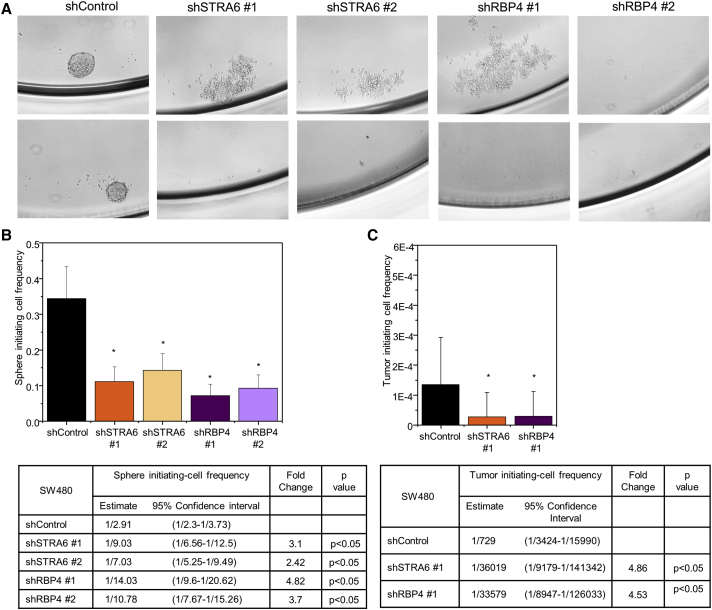
STRA6 and RBP4 Maintain CSC Frequency(A) Low-magnification images of SW480 cells grown as non-adherent spheres. Loss of sphere formation ability upon STRA6 or RBP4 knockdown is shown.(B) (Upper panel) Sphere-initiating cell frequency from an in vitro limiting dilution assay was calculated using ELDA software. A representative frequency estimate calculated from 24 biological replicates of each cell dose is shown. Error bars represent 95% confidence intervals. ∗p < 0.05. (Lower panel) Stem cell frequency estimates within confidence intervals and fold-change differences between control and designated lines.(C) (Upper panel) SW480 cells stably transfected with STRA6 or RBP4 shRNA were injected at limiting doses into NOD-SCID gamma mice (n = 5–6 for each dose) and the ability to initiate tumor formation was evaluated. Plots show tumor-initiating cell frequency calculated using ELDA software. Error bars represent 95% confidence intervals.∗p < 0.05. (Lower panel) Stem cell frequency estimates within confidence intervals and fold changes between control and indicated lines.